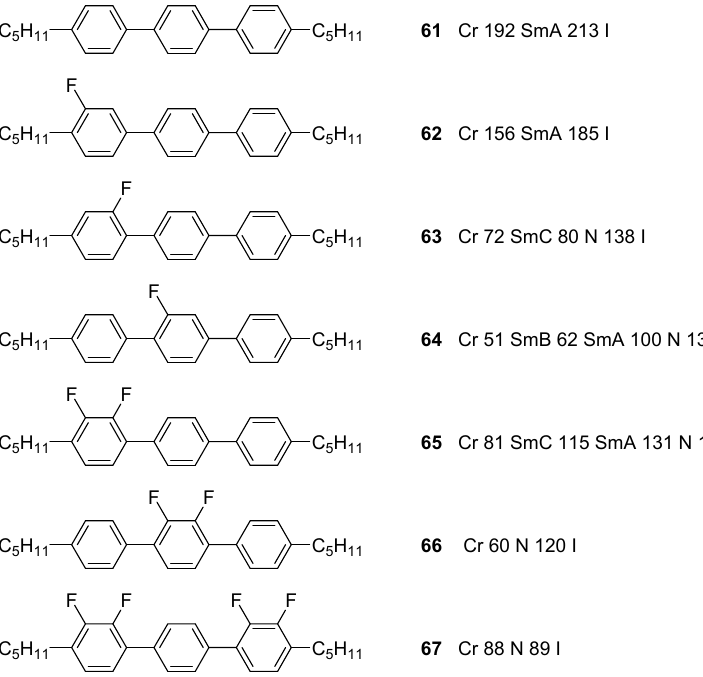
Figure 14. ArImAr mesogens 58 take a nearly flat conformation, perfect for (undesired) lateral mesogens-mesogen interactions. Introduction of small substituents on the 2 position or the 4 and/or 5 position of the imidazolium ring ( 59 ) forces the aryl rings to twist away from the imidazolium plane and reduces the interactions. In addition, phenyl-substitution ( 60 ) may give similar results. Int. J. Mol. Sci. 2016 , 17 , 731